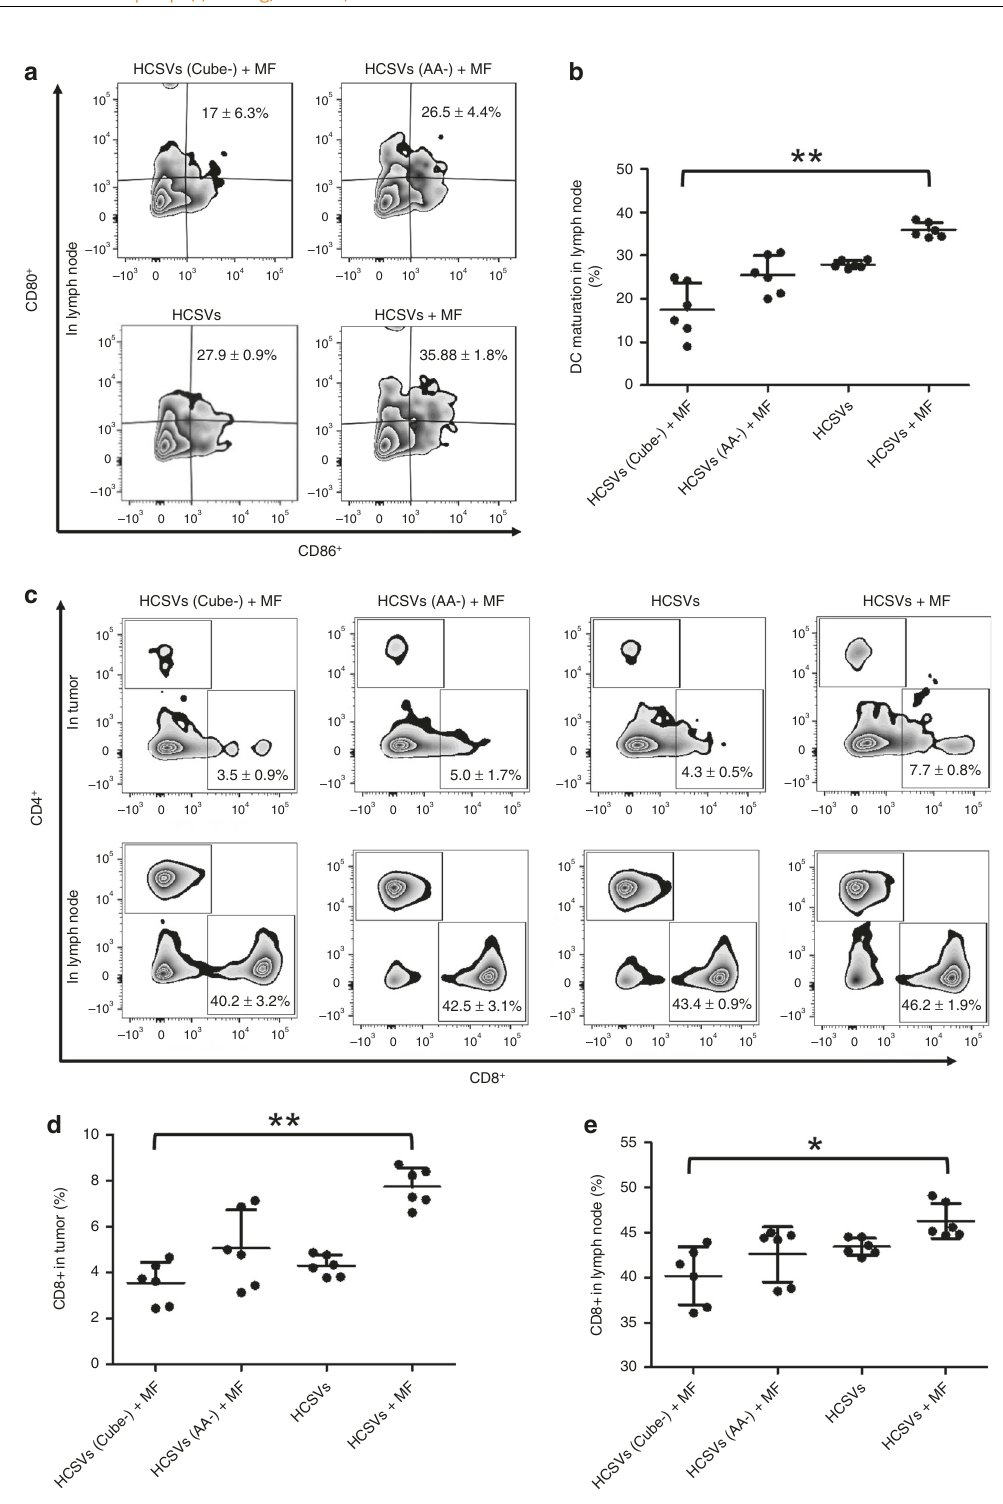
Fig. 4 Immune responses after treatment to TRAMP-C1 tumor-bearing mice. Flow cytometric analysis images ( a ) and the statistical data ( b ) for in vivo DC maturation. Cells in the tumor-draining lymph nodes were collected after various treatments for the assessment by fl ow cytometry after staining with CD11c, CD80, and CD86. ** p = 0.0044. Representative fl ow cytometric analysis images showing CD8 + T cells (CD3 + CD4 - CD8 + ) from different groups of mice. Proportions of tumor in fi ltrating CD8 + killer T cells in the tumor (up line) and draining lymph nodes (down line) ( c ) and the statistical data in the tumor ( d ) (** p = 0.0013) and in lymph node ( e ) among all cancer cells (* p = 0.0491) ( n = 6 independent samples). The percentage values in the graphs were de fi ned in relation to T cell populations. Data are shown as means ± s.d. two-tailed paired t -test. Source data are provided as a Source data fi